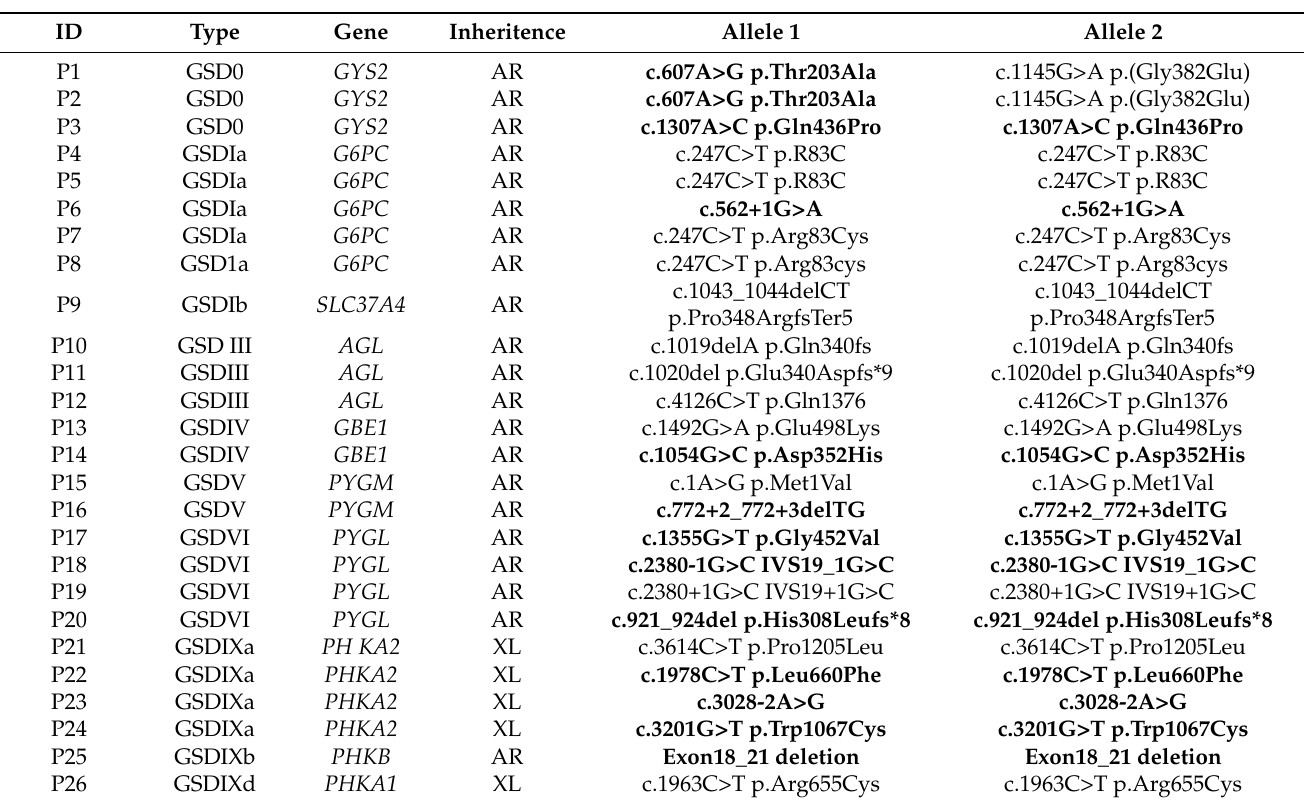
Table 3. Molecular assays of